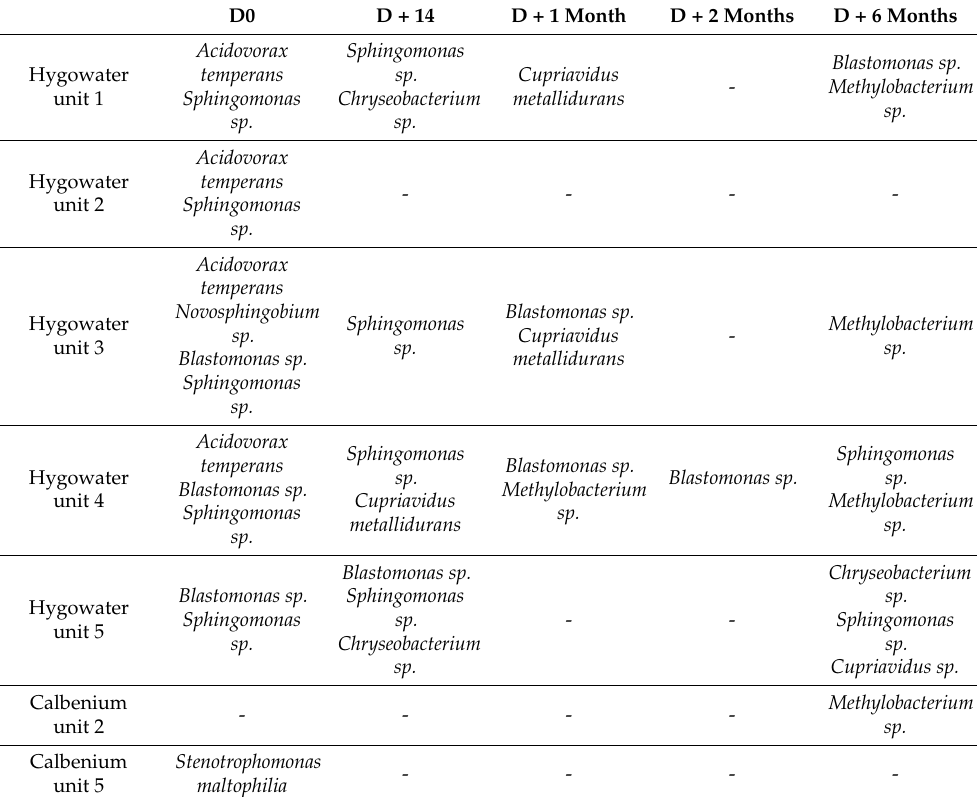
Table 2. Bacterial species incriminated in the contamination of DUWL at different time points.